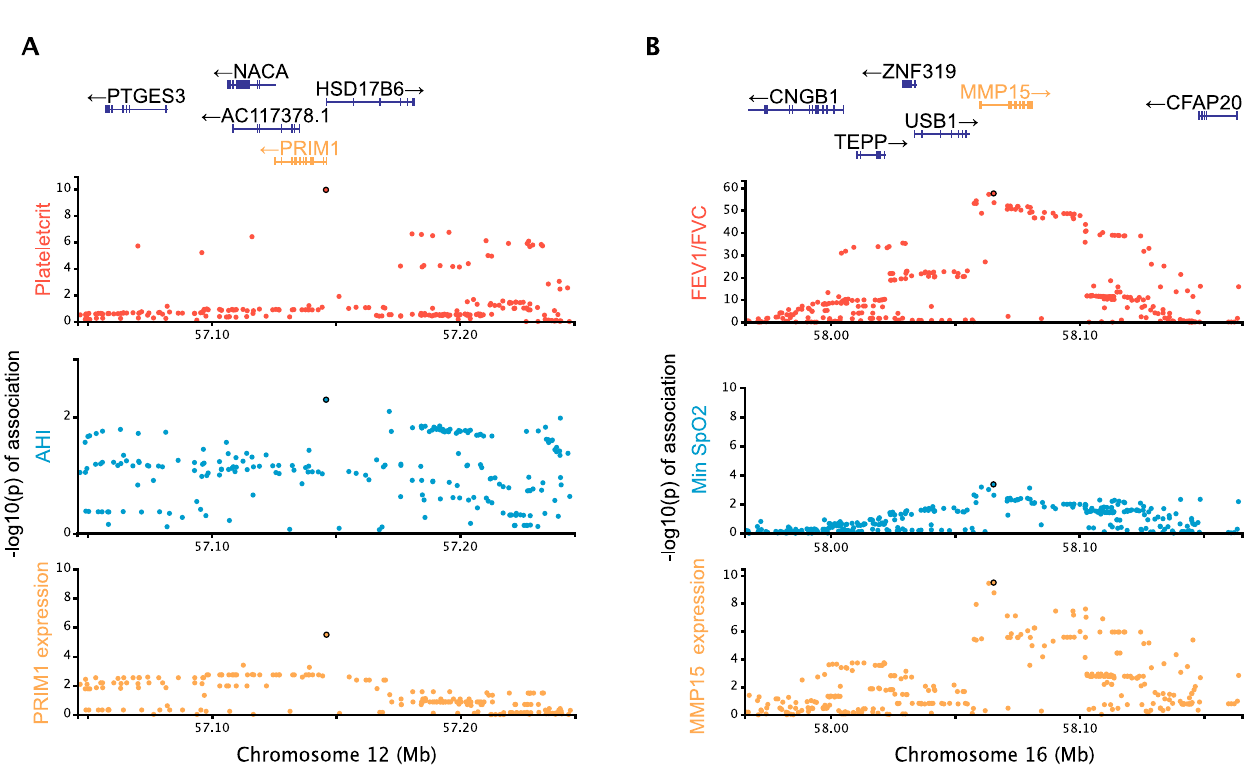
Fig 3. Candidate causal chains linking a clinical trait, OSA trait and gene expression. A) A candidate association in chromosome 12 with putative pleiotropic associations between the plateletcrit (clinical trait; red), AHI (OSA trait; blue) and expression of PRIM1 (DNA primase subunit 1) in monocytes (yellow). B) A candidate association in chromosome 16 with putative pleiotropic associations between the clinical trait FEV 1 /FVC (red), minimum O 2 saturation (blue) and expression of MMP15 (matrix metallopeptidase 15) in lung (yellow).